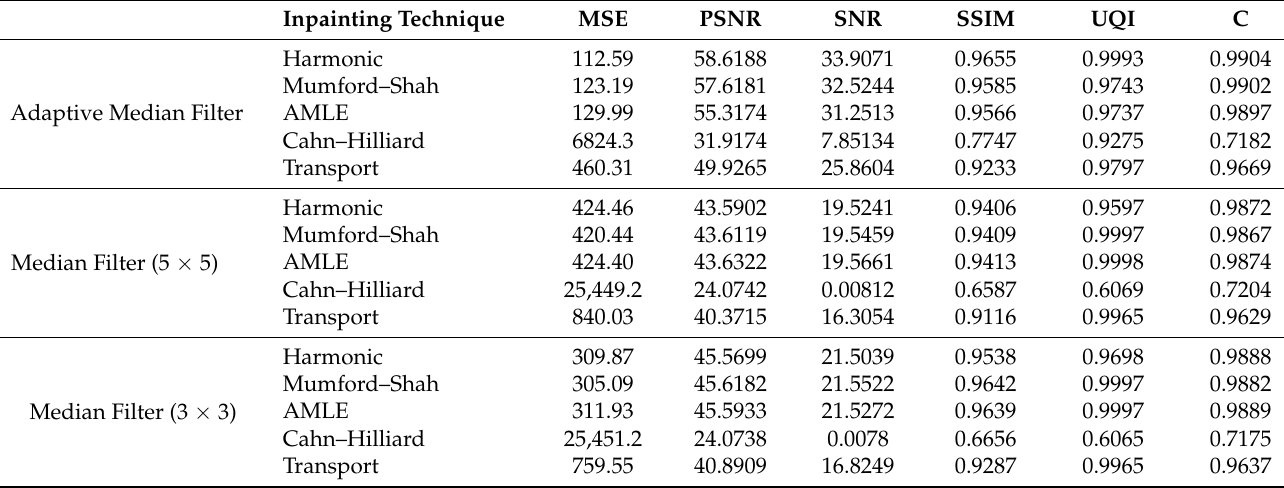
Table 1. Performance quality metrics of the proposed hair removal with different filters and inpainting